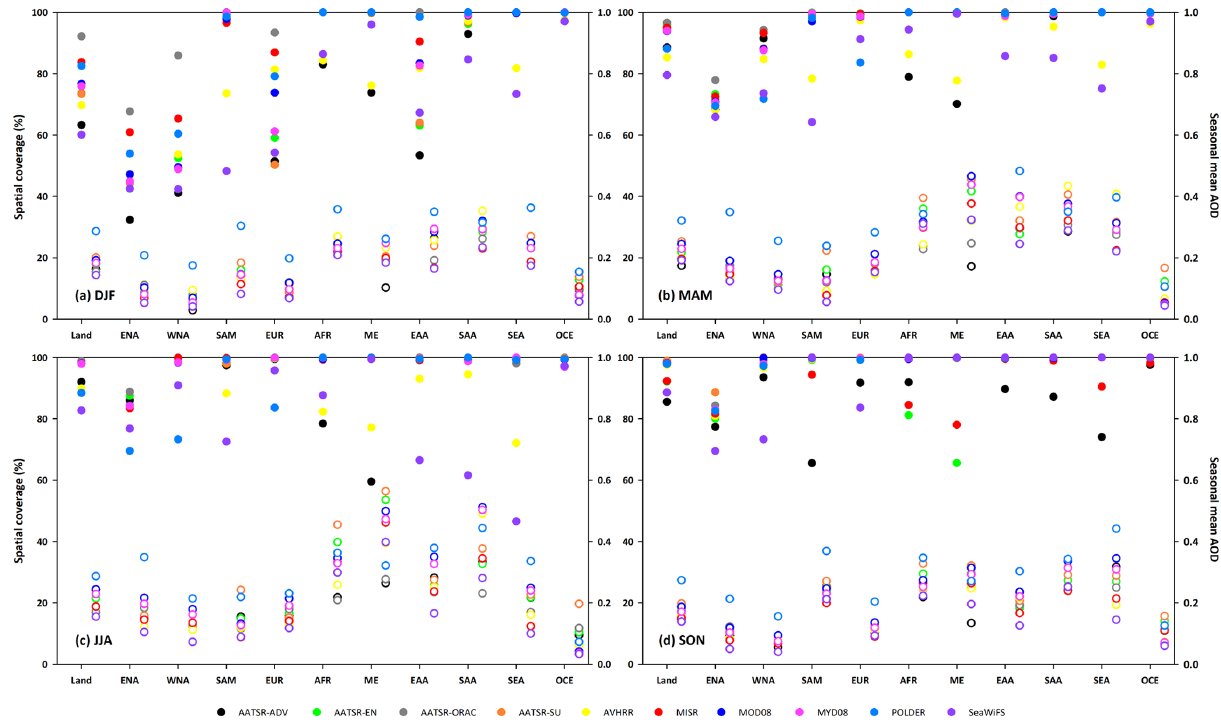
Figure 10. AOD S spatial coverage (marked as solid circles) and seasonal mean (marked as hollow circles) for each customized region over land (refer to Fig. 1) from 2006 to 2010.